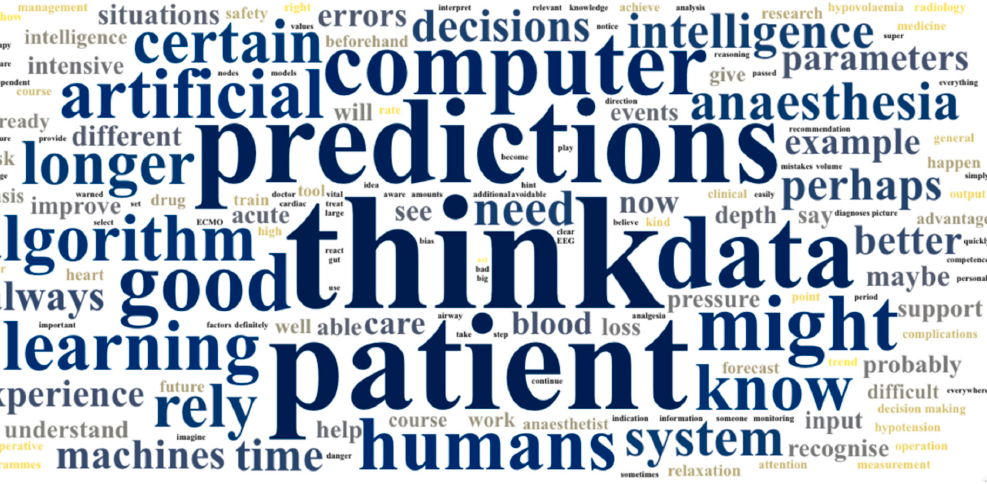
Figure 1. Graphical representation (R version 4.2.0) of the most common words in the participants’ collected answers to all questions. The word cloud makes more frequently used words appear larger.